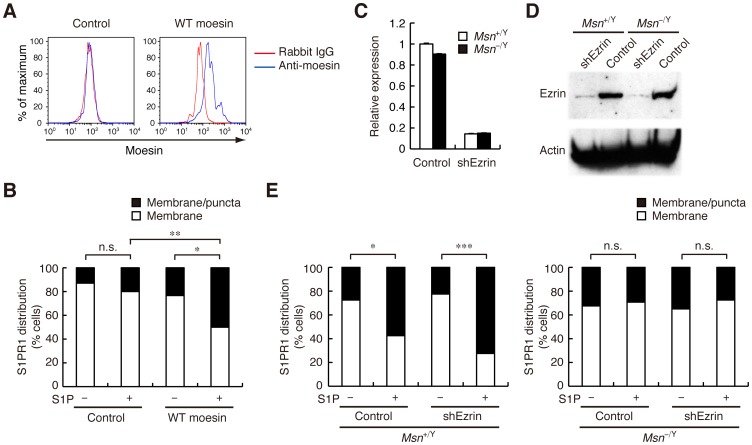
Ezrin is not required for S1PR1 internalization.(A and B) Reintroduction of moesin into moesin-deficient CD4+ T cells. CD4+ T cells from Msn
−/Y mice were transduced with a control vector or a vector encoding WT moesin; transduced cells were identified by GFP expression. Moesin expression in transduced cells (A) and quantification of S1PR1 internalization with or without S1P stimulation (100 nM for 1 h) (B) are shown. (C–E) Ezrin knockdown in CD4+ T cells. CD4+ T cells from Msn
−/Y and Msn
−/Y mice were transduced with a control vector or an ezrin shRNA vector (shEzrin). Transduced cells were selected in the presence of puromycin. Knockdown efficiency was confirmed by real-time RT-PCR (C) and Western blot analysis (D). Quantification of S1PR1 internalization in ezrin-knockdown CD4+ T cells with or without S1P stimulation (100 nM for 1 h) (E) is shown. (B and E) n>50 cells for each group. ***, P<0.001; **, P<0.01; *, P<0.05; n.s., not significant (Fisher's exact test).